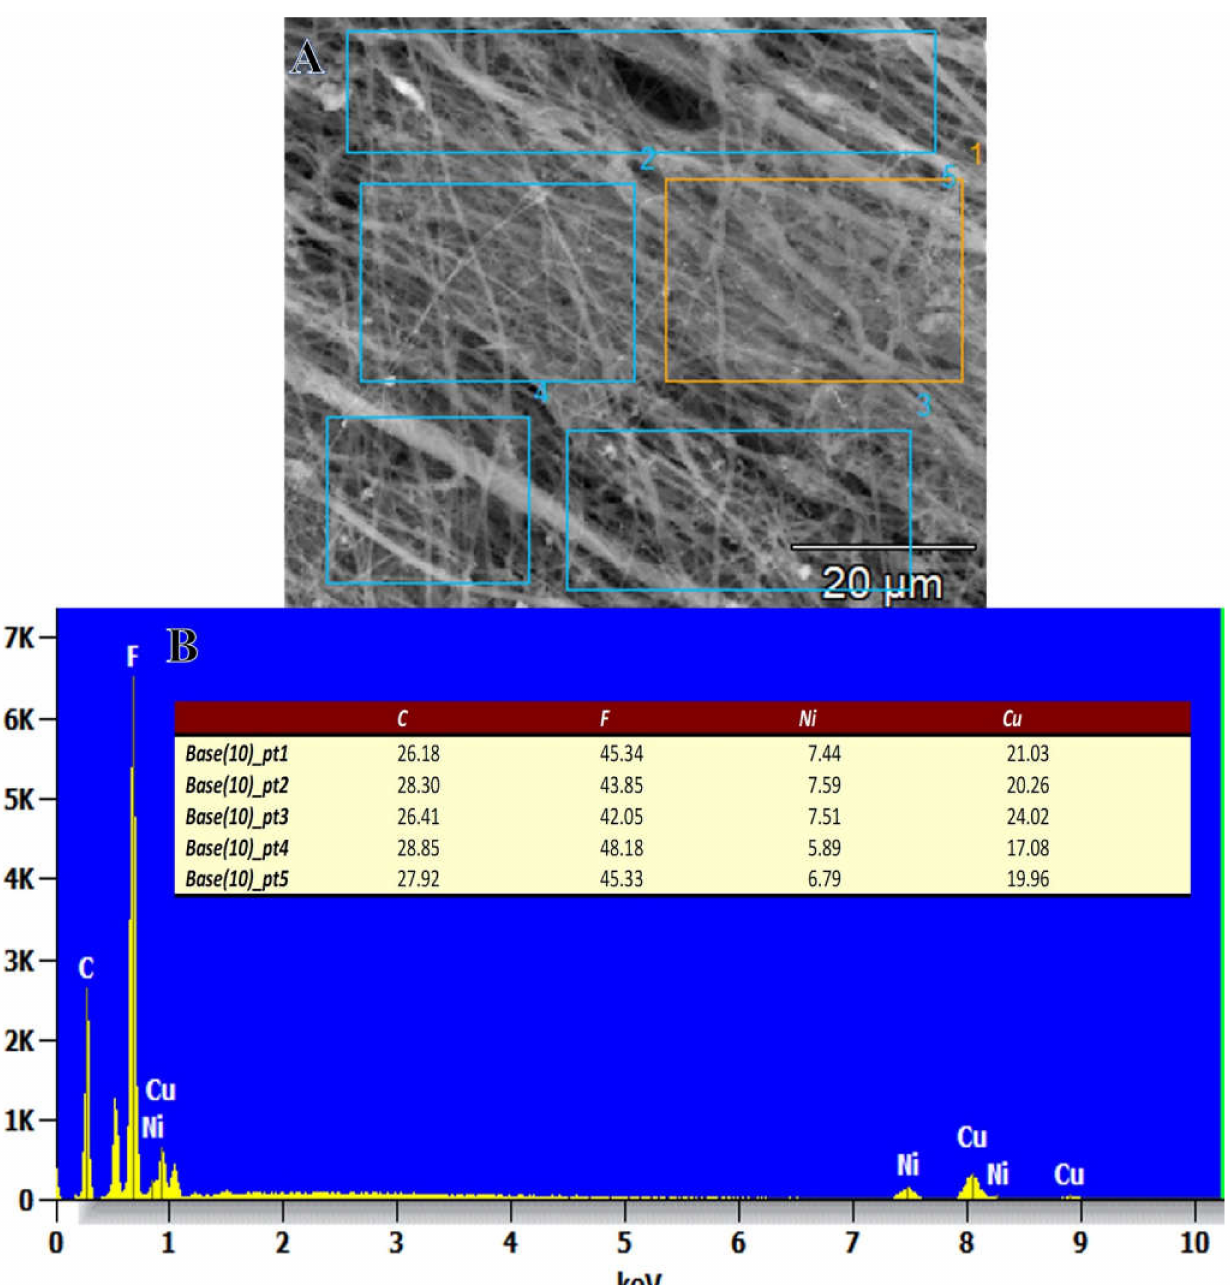
Figure 3. ( A ) SEM image and ( B ) EDX chart of Ni 0.3 Cu 0.7 /PVDF-HFP NF membrane at different SEM image